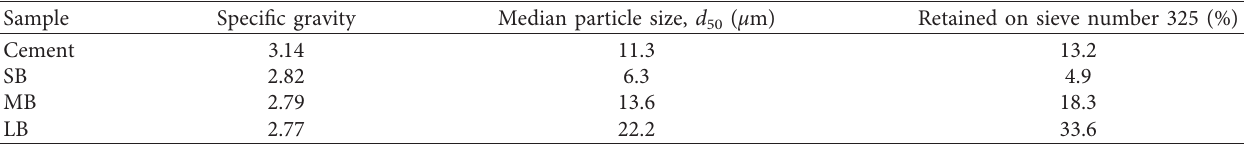
Table 2: Physical properties of materials.